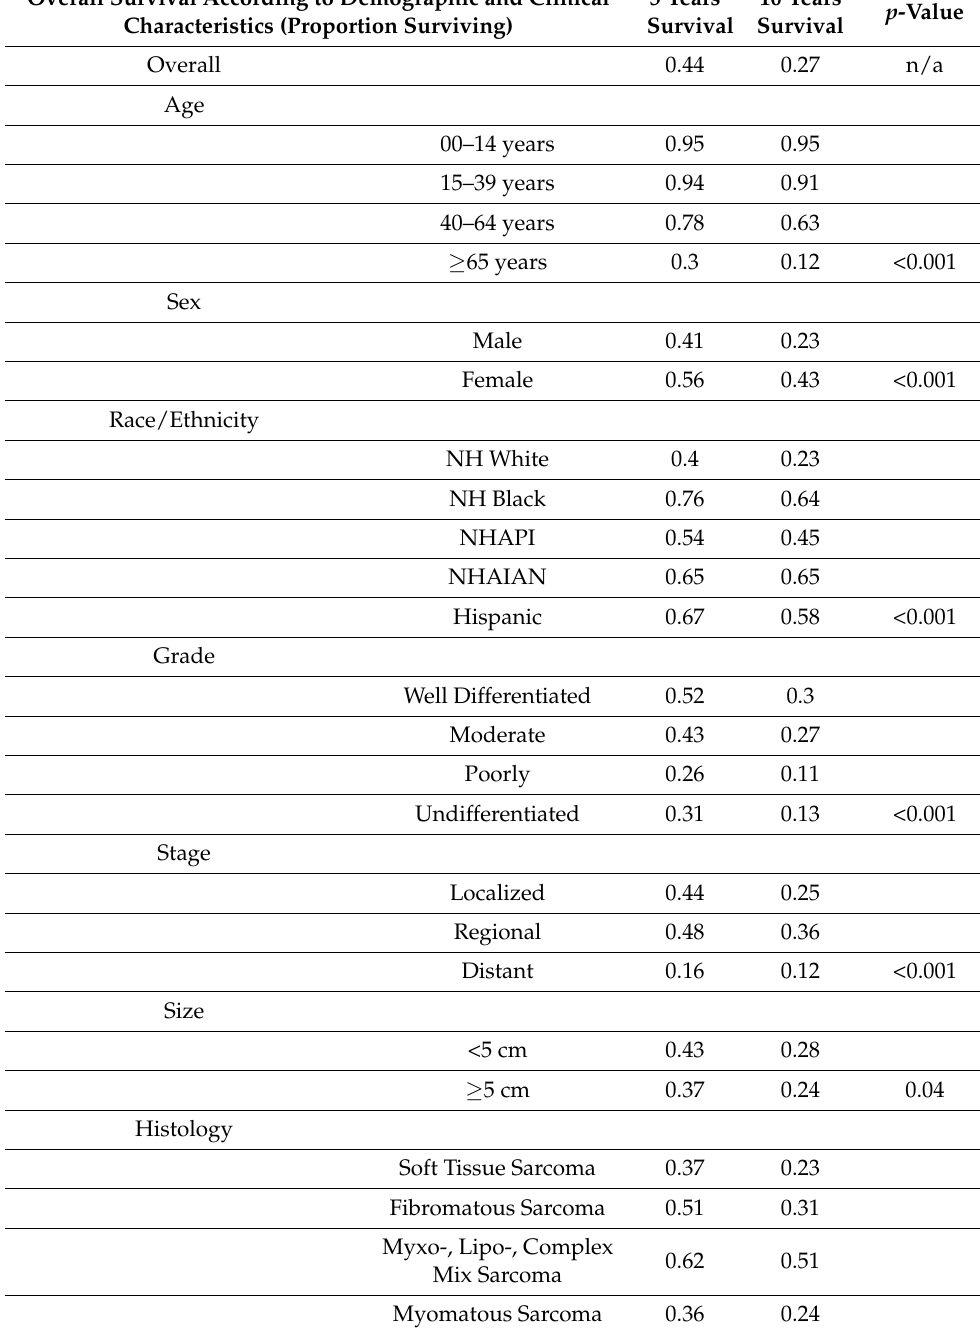
Table 2. Overall survival according to demographic and clinical characteristics (proportion surviving). Overall Survival According to Demographic and Clinical Characteristics (Proportion Surviving)